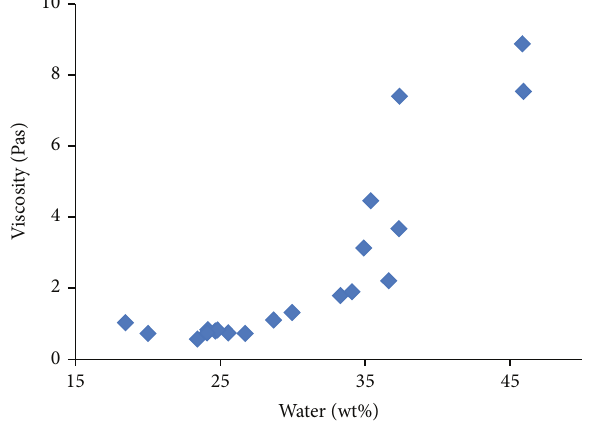
Table 3: Lacquer laccase activities.